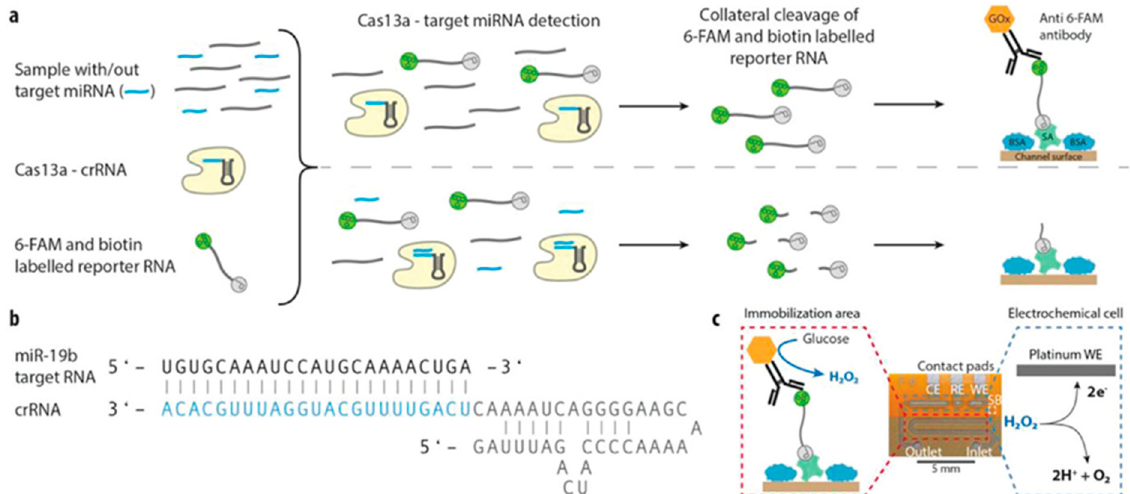
Figure 1. Combination of the CRISPR technology along with an electrochemical microfluidic biosensor for miRNA diagnostics. ( a ) Schematic of the off-chip miRNA targeting including the enzyme Cas13a, the target miRNA (blue), the target-specific crRNA, and the biotin and 6-FAM-labeled reporter RNA, which is immobilized after the cleavage process onto the streptavidin (SA) and BSA blocked channel surface. ( b ) Schematic of the single-stranded target miRNA, miR-19b, and the crRNA, where the complementary sequence is highlighted in blue. ( c ) Working principle and photo of the microfluidic biosensor with its main elements including the contact pads for the working, reference, and counter electrode (WE, RE, CE) in the electrochemical cell (marked in blue) and the immobilization area for the assay preparation (highlighted in red), separated by the hydrophobic stopping barrier SB, reproduced with permission from [36] Copyright 2020 Wiley.